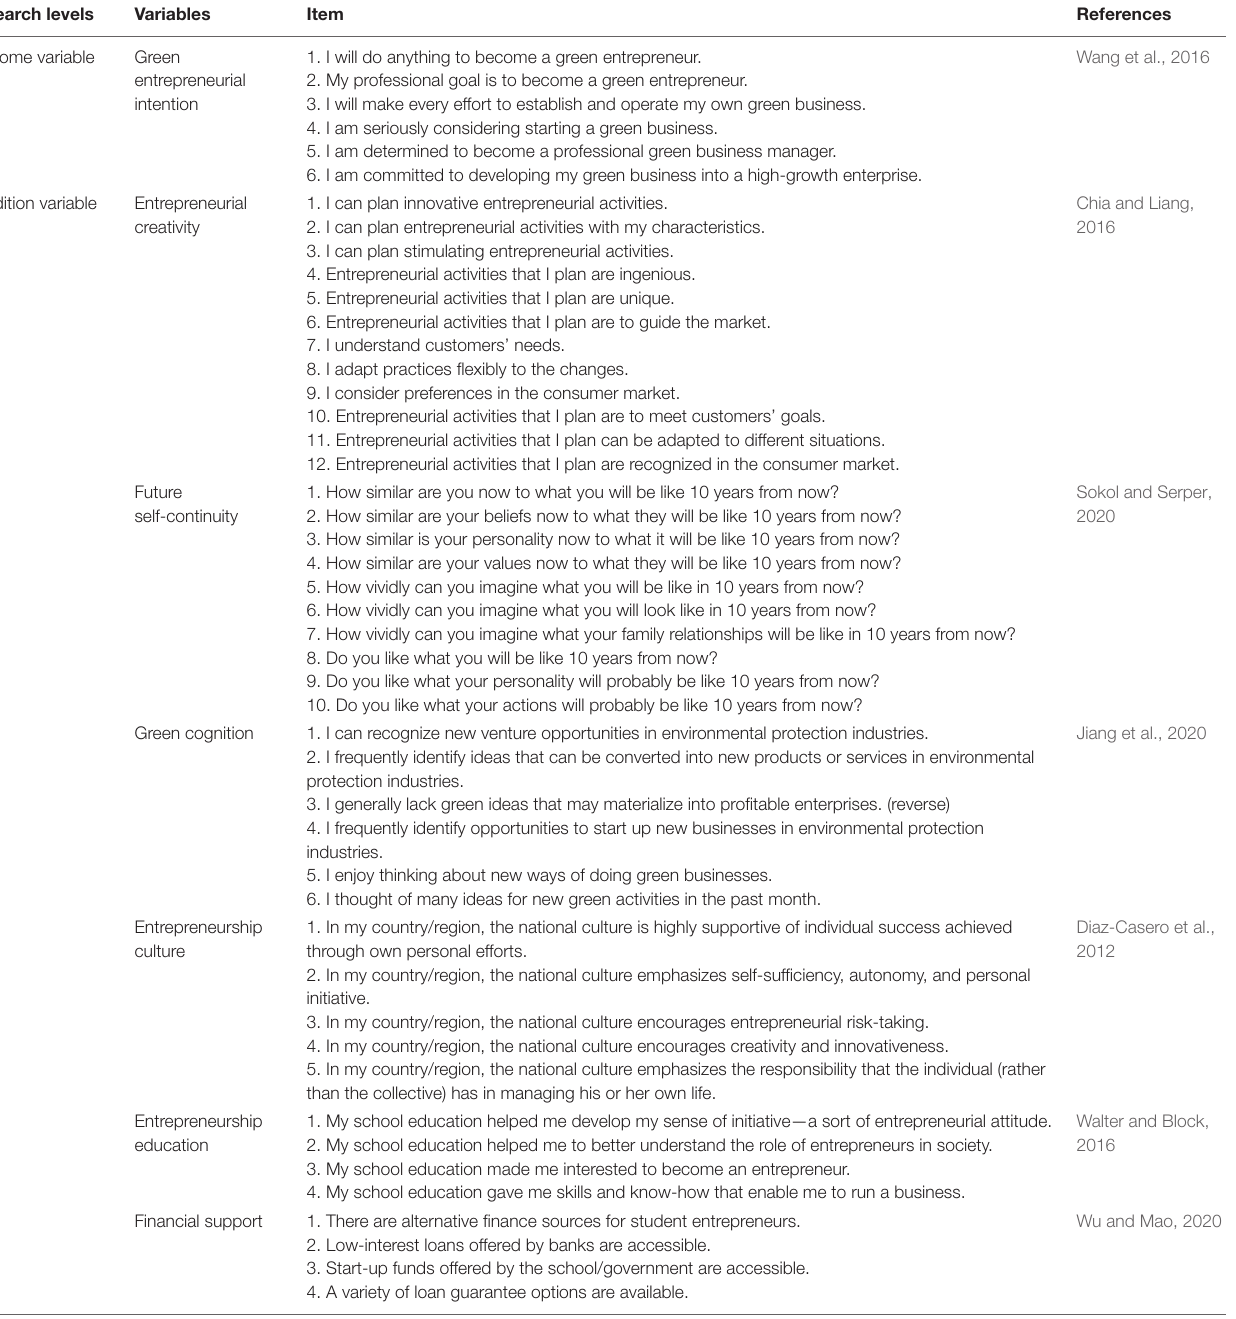
TABLE 1 | The related items of condition variables and outcome